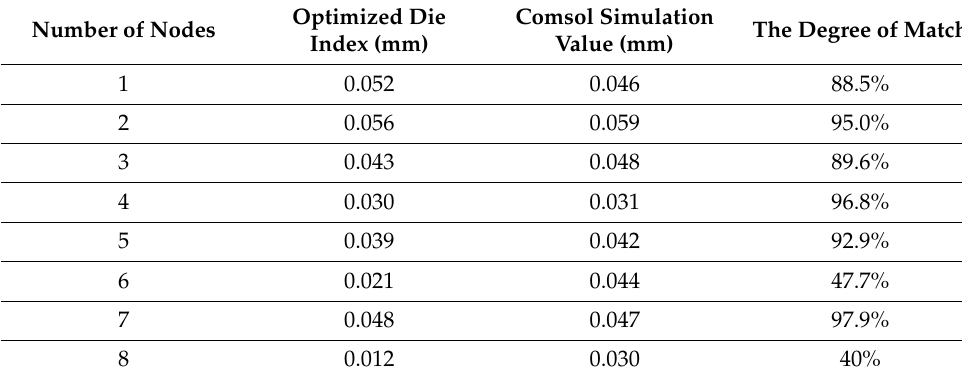
Table 2. Comsol stress simulation results match the die index table.